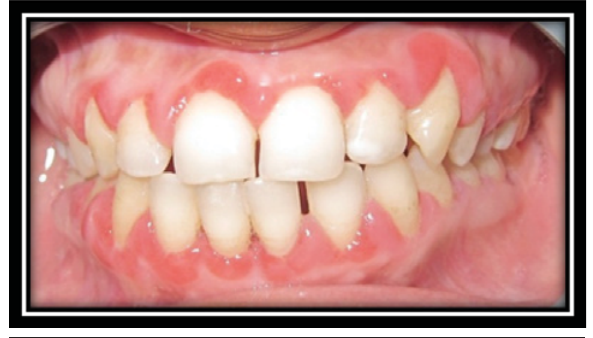
Figure 2. Four weeks after mechanical debridement